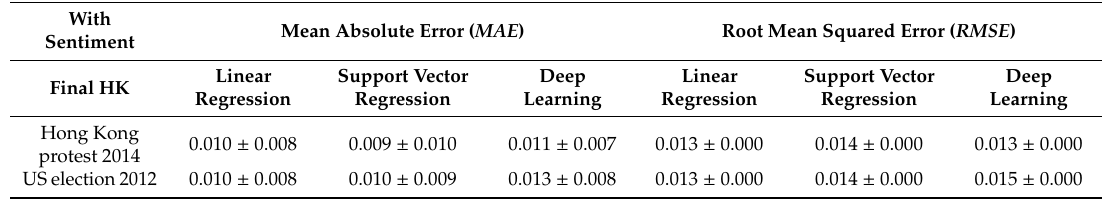
Table 6. Results for Hong Kong (HK) with event sentiments.